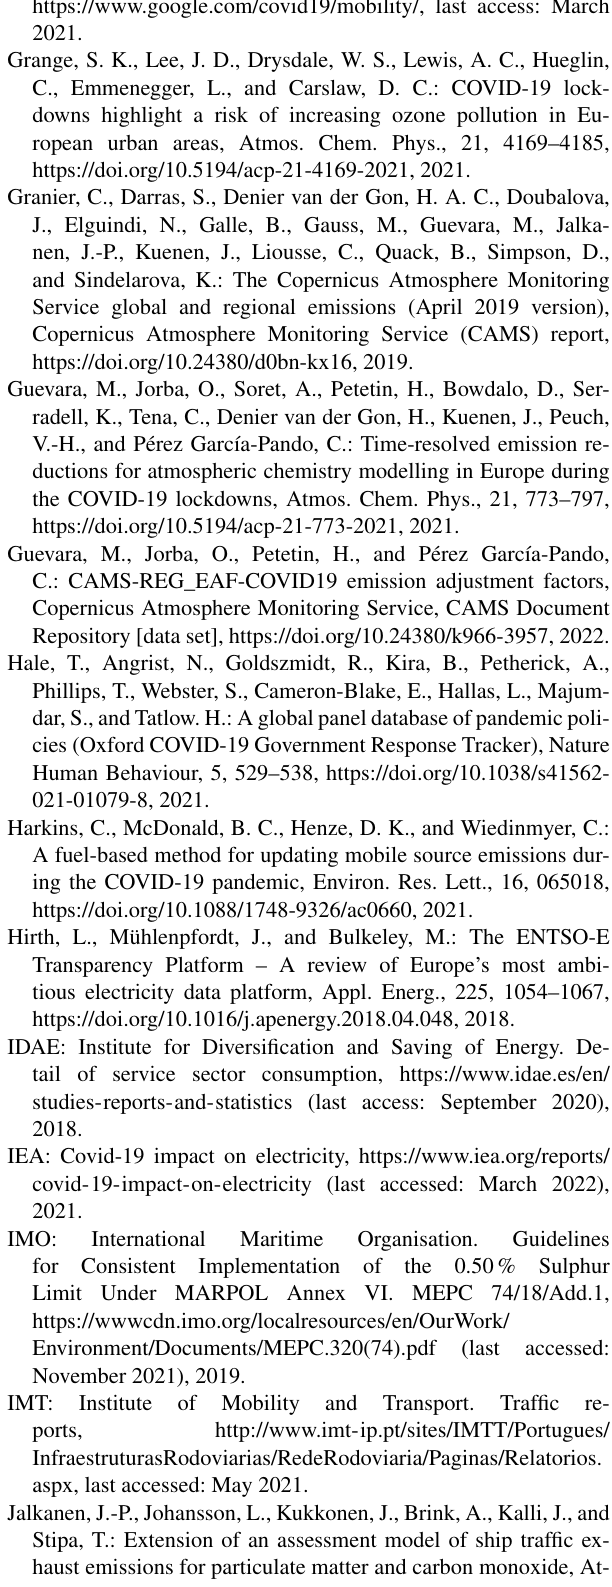
for Consistent Implementation of the 0.50% Sulphur Limit Under MARPOL Annex VI. MEPC